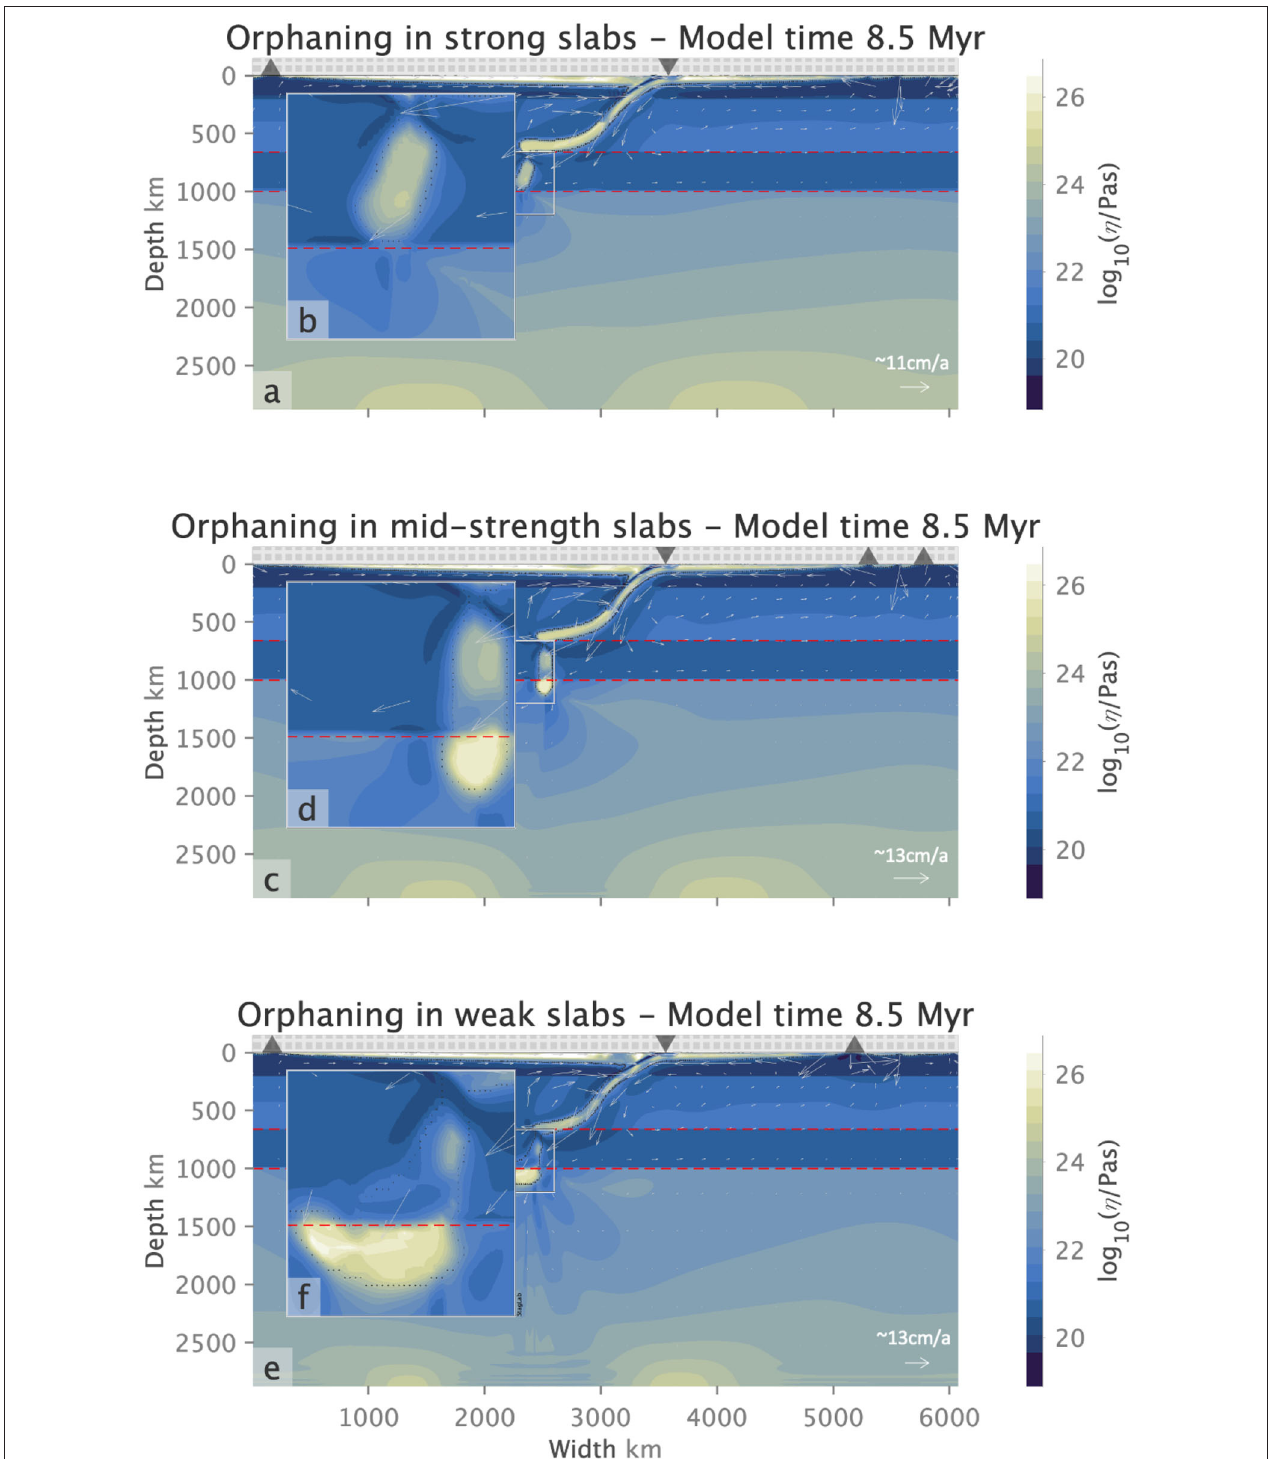
FIGURE 6 | Slab orphaning for slab yield stress values of 600 MPa (a,b) , 400 MPa (c,d) , and 200 MPa (e,f) with respective Clapeyron slope values of 2.5 MPaK − 1 . Variations in orphan slab viscosity across (a–e) reflect the variations in the slab yield stress. Slabs with lower yield stresses produce weaker orphans − that deform more [compare (b,d) with (f) ]. (c–f) Show penetration of the orphan slab tip into the lower mantle due to the large size of the proto-orphan. In both cases the proto-orphan slab tip penetration occurs before orphaning and does not influence it. Flow arrows indicate the sense of flow direction and its relative magnitude for each figure.